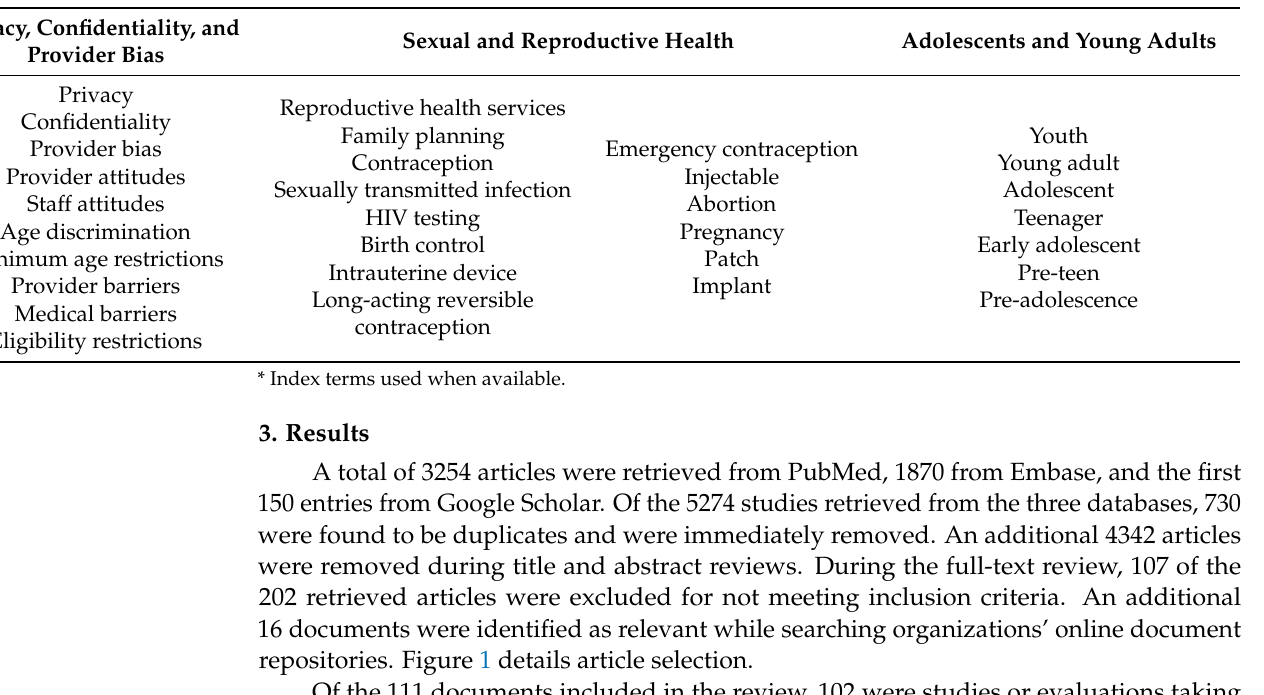
Table 2. Key search terms used to detect database literature (PubMed, Embase, Google Scholar) *.